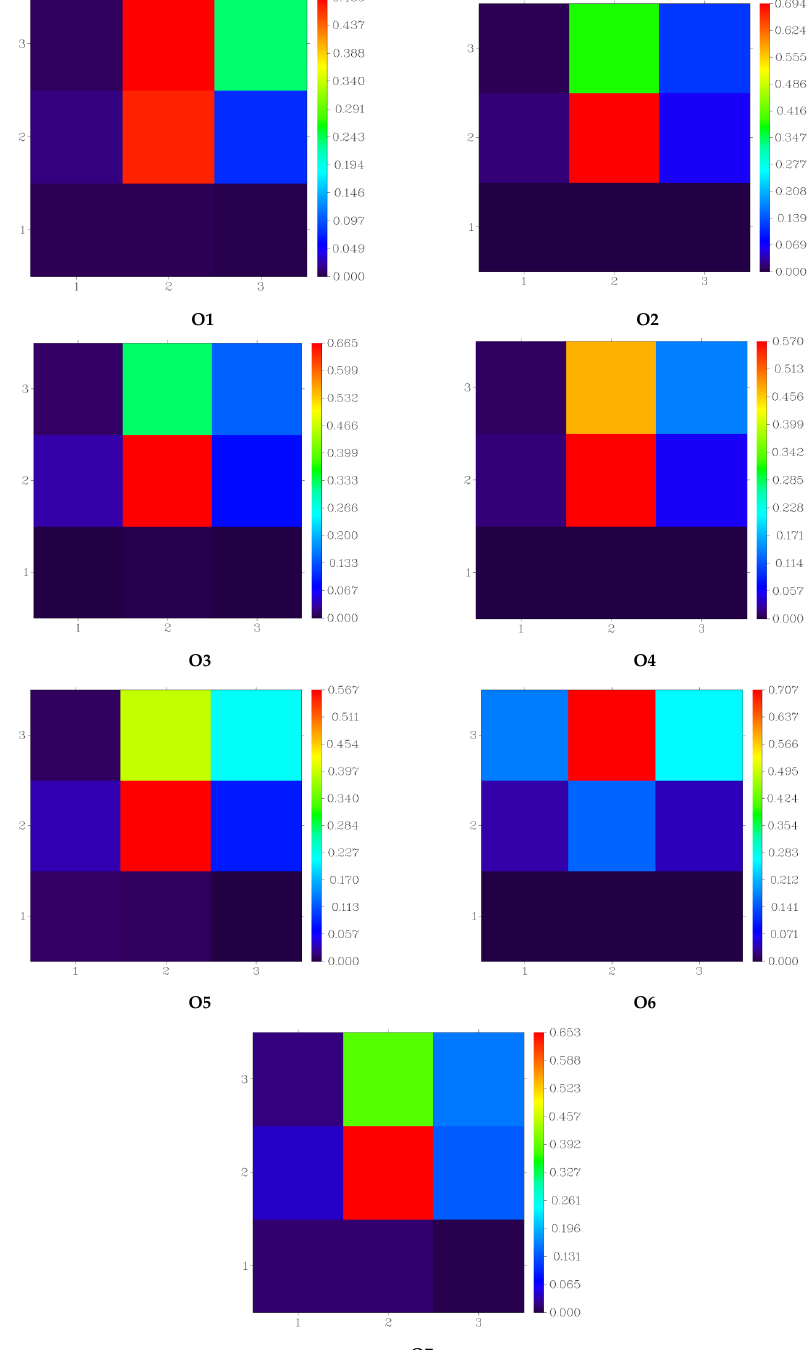
Figure 10. Transition density matrix of molecules demonstrating electron distribution from donor core to acceptor moieties.